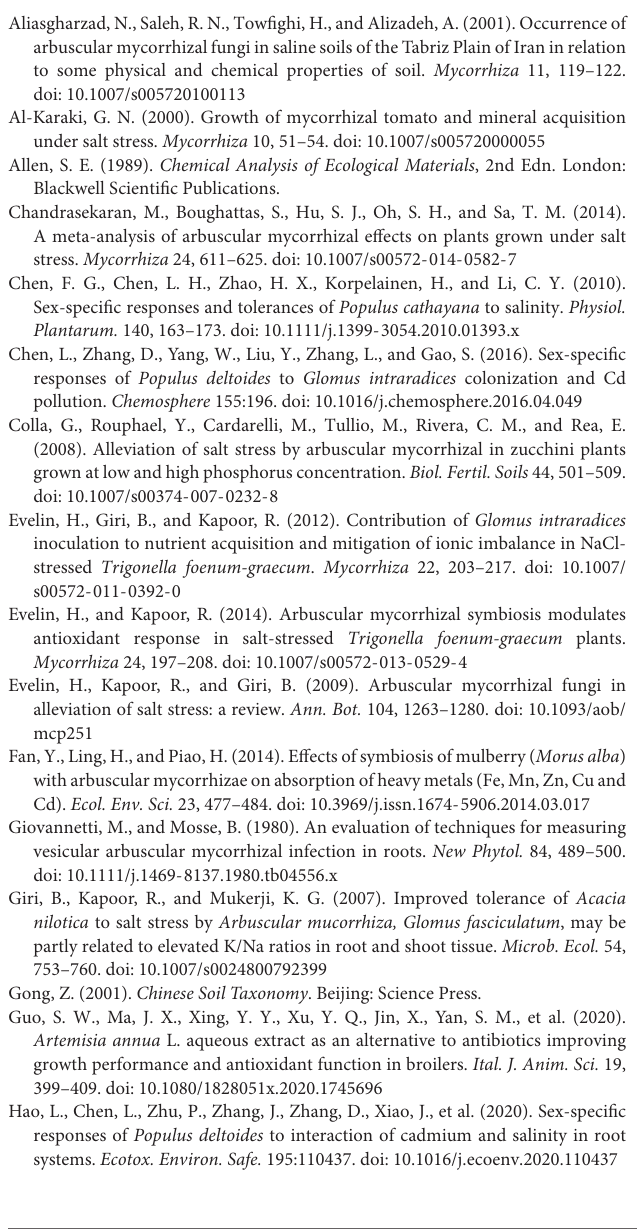
Supplementary Figure 3 | Principal component analysis of growth, photosynthetic properties, biochemical parameters, nutrient concentrations, and the treatment groups of salinity, sex, and arbuscular mycorrhizal fungus. MC, mycorrhizal colonization; MGR, mycorrhizal growth response; A , net photosynthetic rate; g s , stomatal conductance; E , transpiration rate; WUE, instantaneous water use efficiency; TDW, total dry weight; RSR, root/shoot ratio; POD, peroxidase; Pro, proline; SP, soluble protein; SKNa, K + /Na + ratio in shoot; RKNa, K + /Na + ratio in root; SCaNa, Ca 2 + /Na + ratio in shoot; RCaNa, Ca 2 + /Na + ratio in root; SMgNa, Mg 2 + /Na + ratio in shoot; RMgNa, Mg 2 + /Na + ratio in root; NaR, shoot/root ratio of Na + . The codes for treatment groups are as follows: MCN, male plants under 0 mM NaCl and without mycorrhizal inoculation; MLN, male plants under 50 mM NaCl and without mycorrhizal inoculation; MHN, male plants under 200 mM NaCl and without mycorrhizal inoculation; MCA, male plants under 0 mM NaCl and with mycorrhizal inoculation; MLA, male plants under 50 mM NaCl and with mycorrhizal inoculation; MHA, male plants under 200 mM